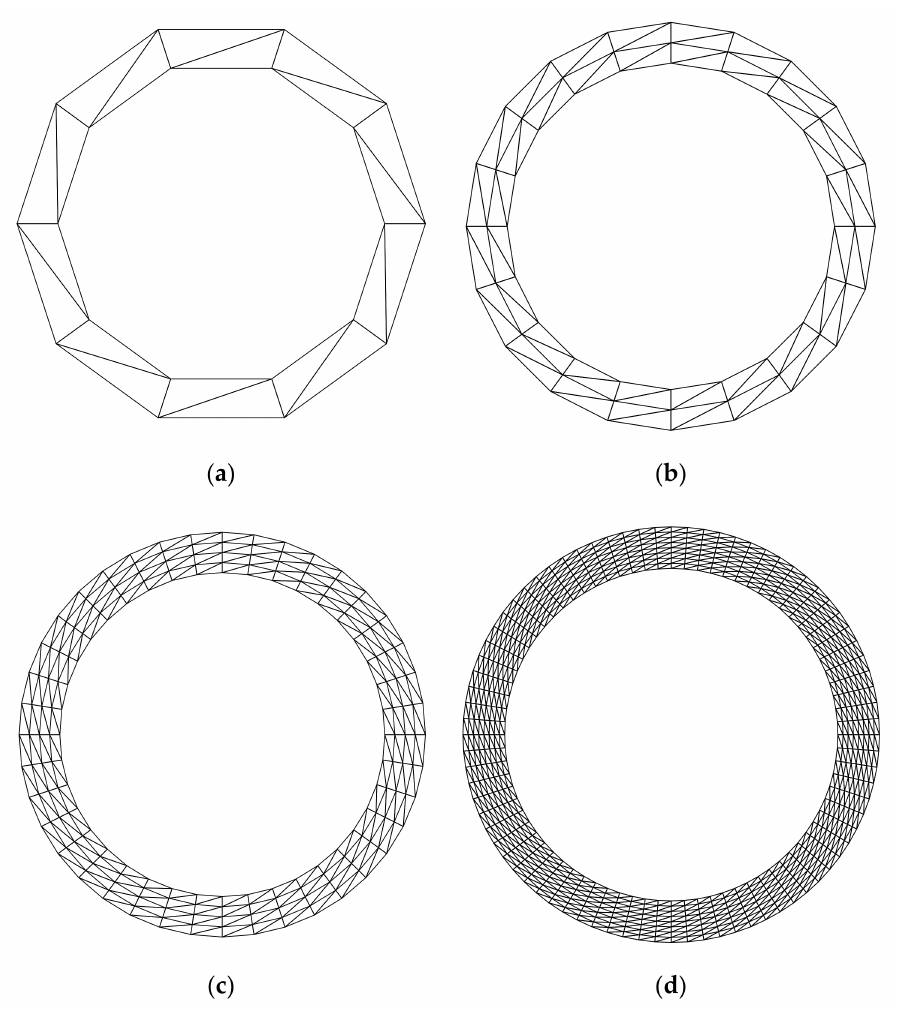
Figure 10. Triangular meshes for the annulus. ( a ) Mesh A (20 elements, 20 nodes); ( b ) Mesh B (80 elements, 60 nodes); ( c ) Mesh C (320 elements, 200 nodes); ( d ) Mesh D (1280 elements, 720